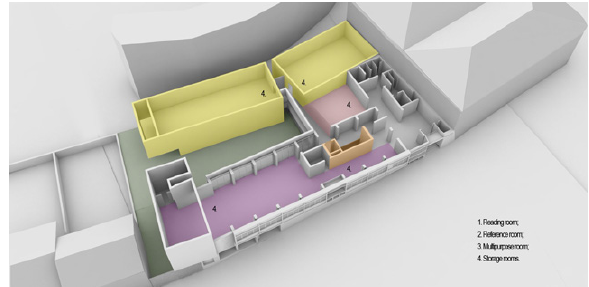
Figure 12. Proposed first floor